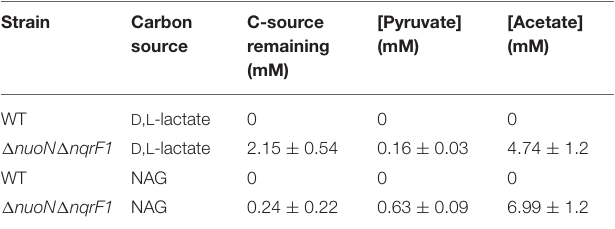
TABLE 4 | Endpoint HLPC analysis of carbon source utilization from 24-well plate experiments with WT and 1 nuoN 1 nqrF1 containing the Rex redox sensor